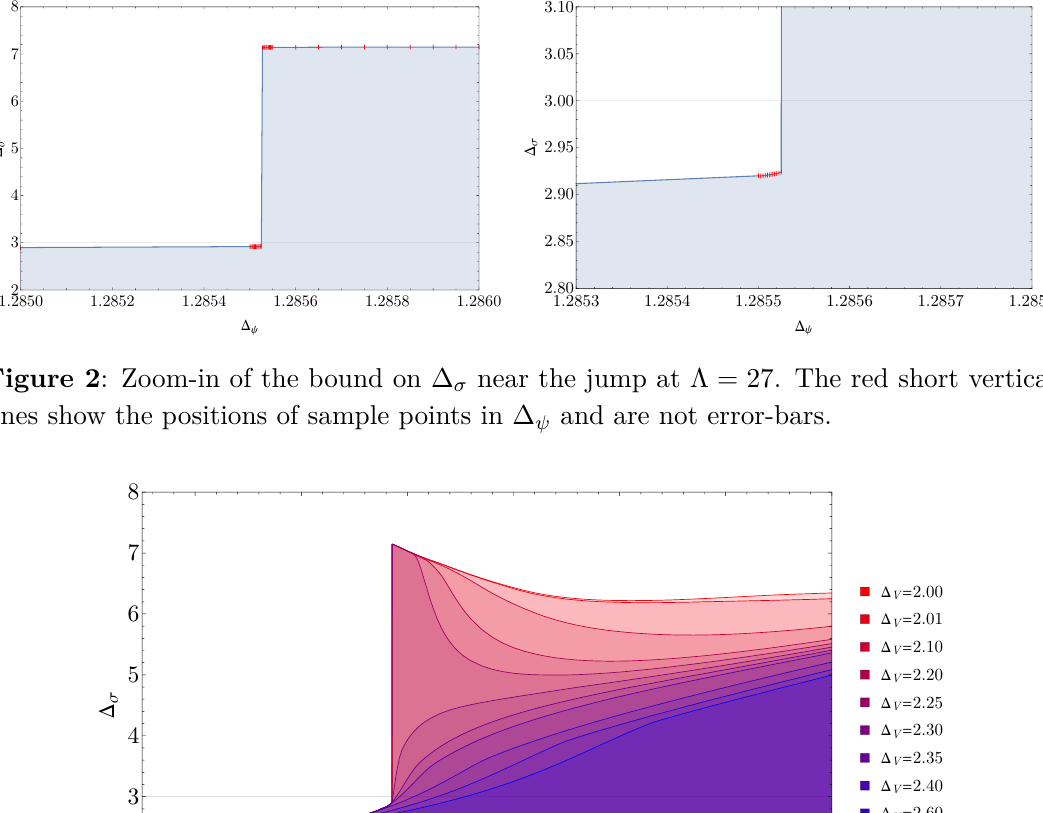
in the parity-odd scalar sector at Λ = 27 for various Figure 3 : The bound on the gap ∆ σ values of the gap ∆ ∈ [2 , 3]. The gaps are listed on the right in the same order as V the curves appear in the plot, top to bottom. The jump disappears between ∆ and ∆ = 2 . V